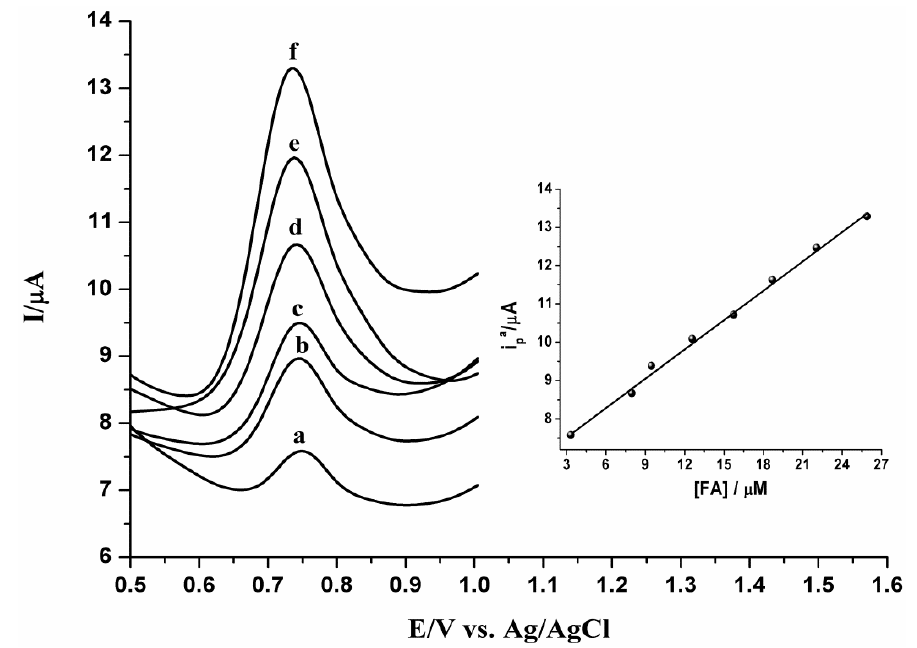
Figure 5. SW voltammograms obtained under optimal conditions of pH 3.5, accumulation potential of − 0.40 V, accumulation time of 60 s, and frequency of 30 Hz in 0.2 M H 3 PO 4 solution containing different concentrations of FA (concentration increases from curve a to curve f: 3.32, 7.96, 9.46, 15.70, 18.70 and 25.90 × 10 − 6 M, respectively). Inset: Calibration curve for FA on a PPy-MWCNTs/GC-modified